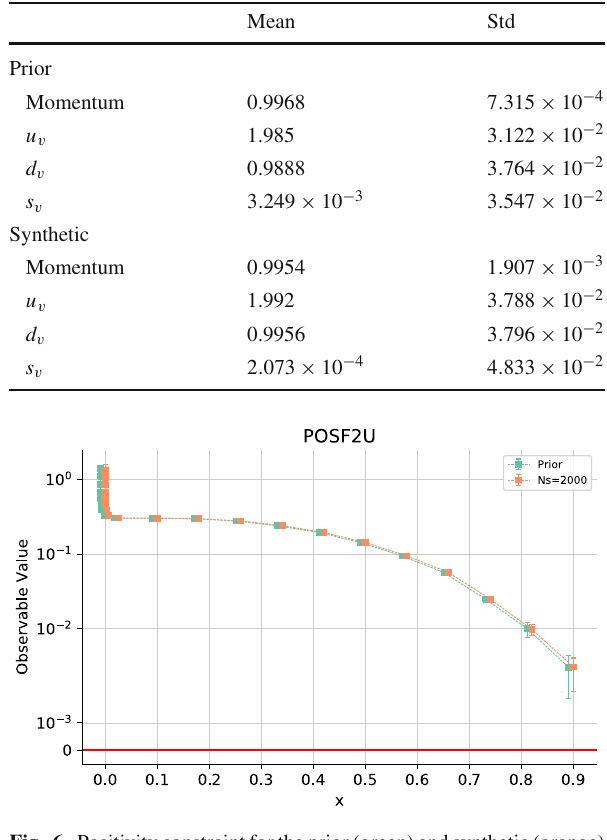
Fig. 6 Positivity constraint for the prior (green) and synthetic (orange) PDF sets. These constraints corresponds to the positivity observable ( x ) introduced in Eq. (14) of F u 2